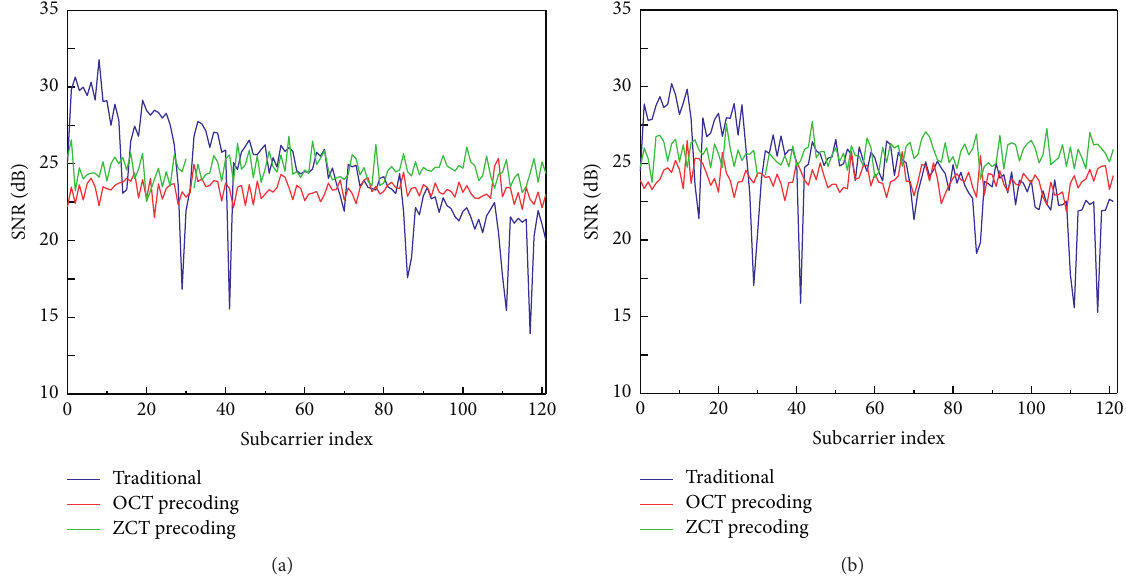
Figure 4: The SNR profiles of different MIMO-OFDM VLC schemes (DC � 2V, Vpp � 2V): (a) the SNR profiles of RX1; (b) the SNR profiles of RX2.